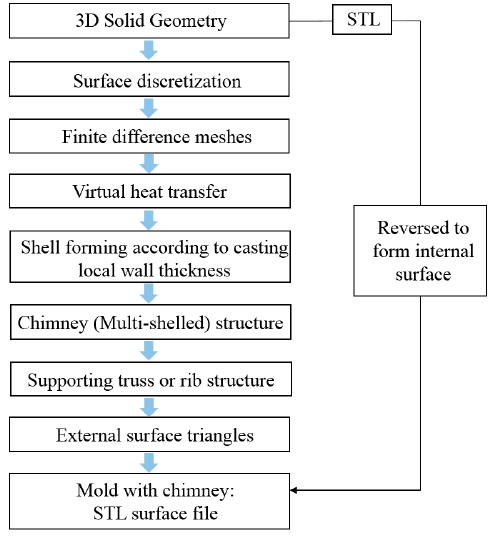
Figure 3. Design flowchart for chimney structure.